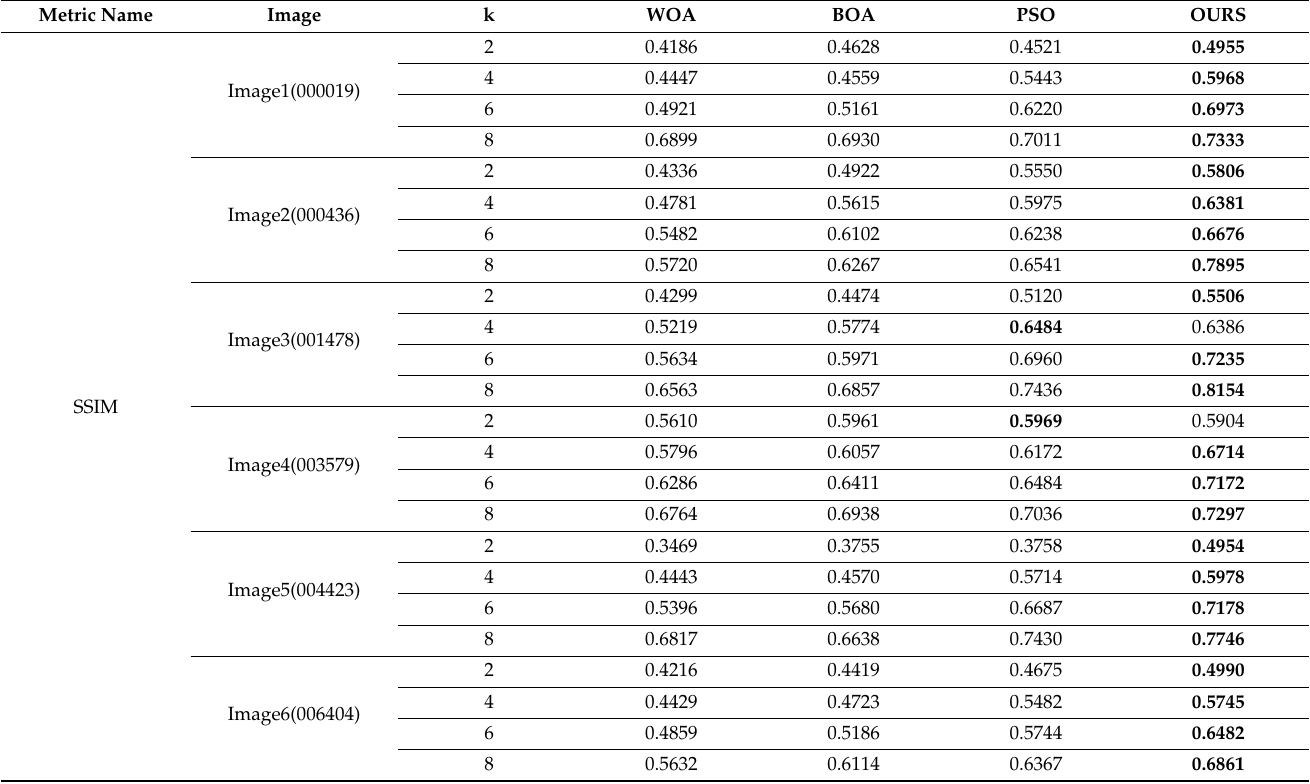
Table 4. Comparison of SSIM in images